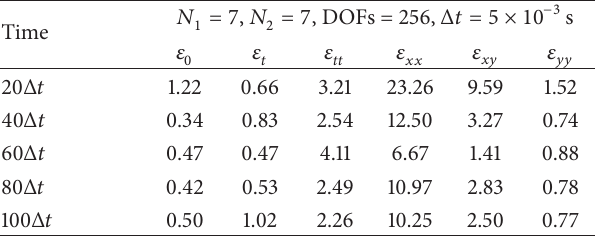
Table 4: Global errors of the finite method with Hermite element. Time